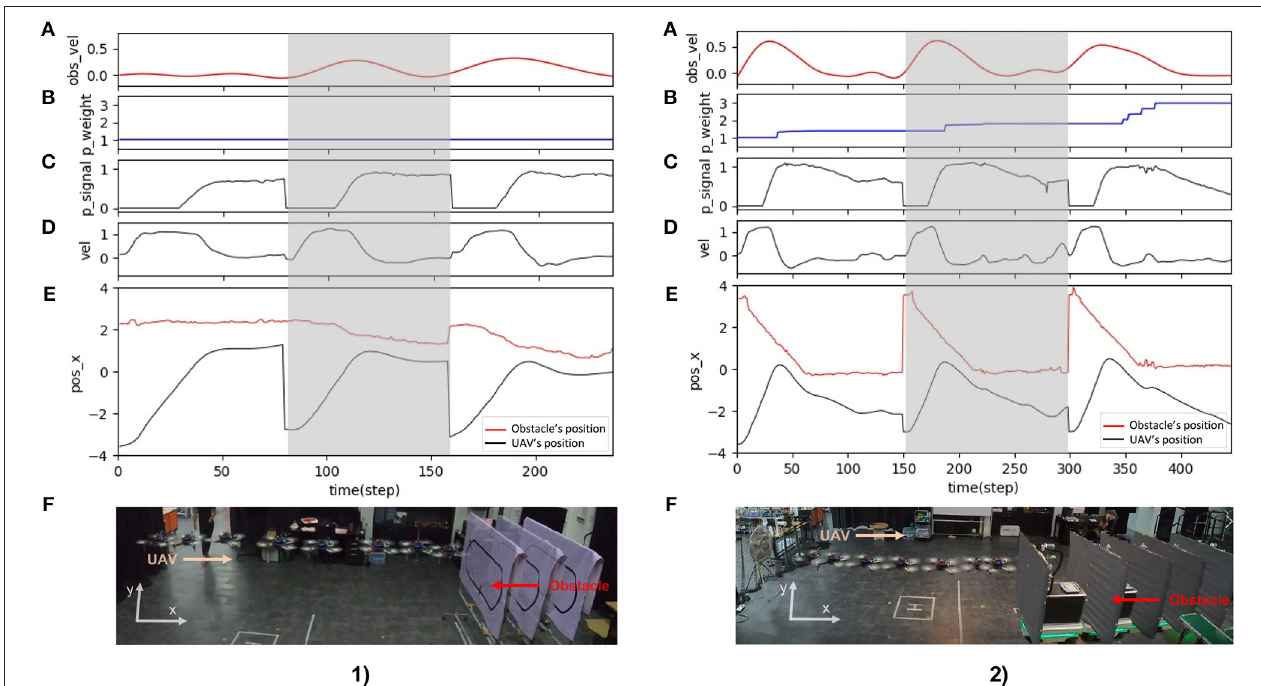
FIGURE 16 | Real-time data of speed adaptation with a dynamic obstacle when flying the UAV in the real environment at a maximum speed of 1.0 m/s and a predictive weight of 1.07. (1) The obstacle speed was approximately 0.25 m/s. The obstacle was moved by a human. (2) The obstacle speed was approximately 0.5 m/s. The obstacle was moved by a mobile robot. (A) Actual obstacle speed. (B) Predictive Weight. (C) Predictive signal. (D) Actual speed (x-axis) of the UAV. (E) Position on the x-axis of the UAV and obstacle. (F) Automatic flying behavior of the UAV (see from left to right) from the gray area period of the above graphs. A video of this experiment can be viewed on